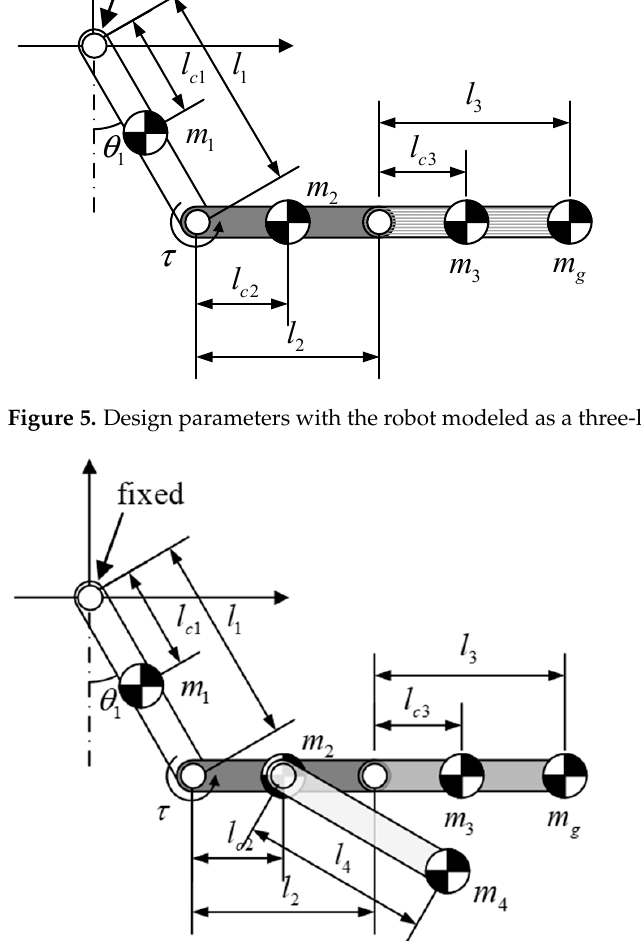
( b ) Figure 7. Three-dimensional CAD drawing of proposed transverse brachiation robot: ( a ) front view; ( b ) back view. As shown in Figure 7, the mechanical transmission system includes wrist joints, arm joints, and a tail joint. We employed passive wrist joints to facilitate the accumulation of kinetic energy during the swing phase. Note, however, that passive wrist joints render the gripper susceptible to rotational misalignment with the target ledge. We resolved this problem by incorporating a belt mechanism in the wrist joints to enable the gripper of the grasping hand to maintain the same wrist posture as the gripper of the support hand. Actuators transmit power through belt mechanisms to arm joints. An actuator in the tail joint is used to introduce a swinging motion via bevel gears. A slip ring device installed in the body link enables the efficient transmission of power used for tail rotation. 3.2. Gripper for Transverse Ledge Brachiation Unlike bars and cables, the target for ledge brachiation robots is flat. Thus, the grip- per should provide rapid open and close operations to enable the clamping of the rail-like